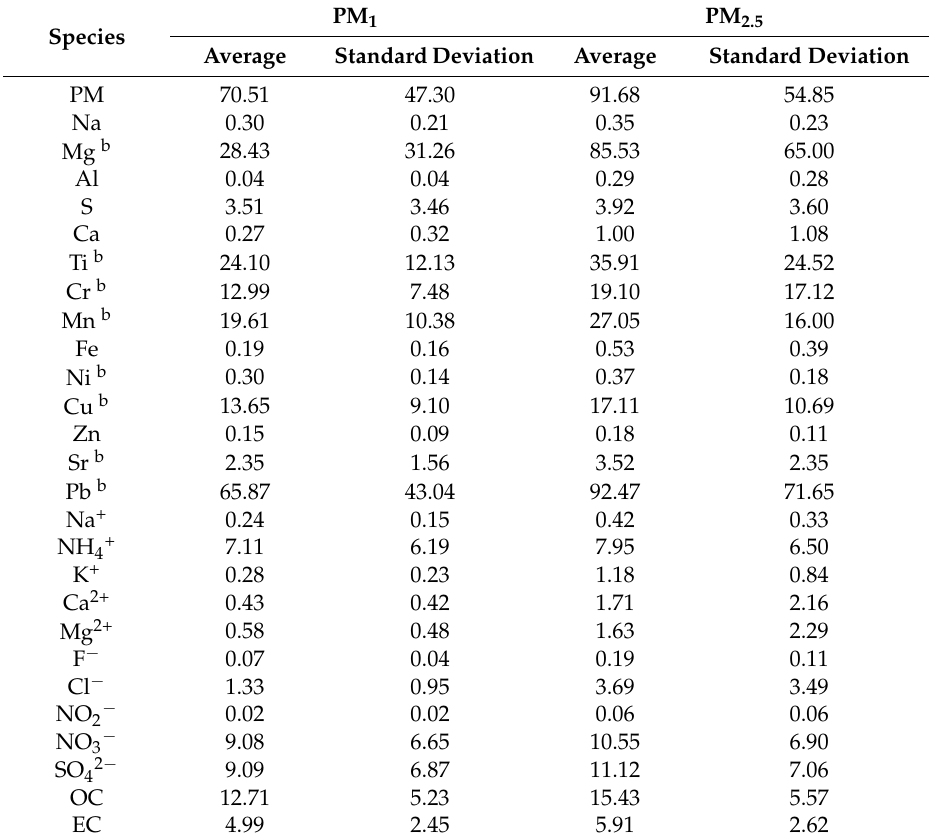
Figure 4. The profiles of chemical components in PM 1 and PM 2.5 . (TE: trace elements; EC: elemental carbon; OM: organic matter; WSII: water-soluble inorganic ions). Table 2. Average mass concentration and standard deviation of chemical species of PM during the study